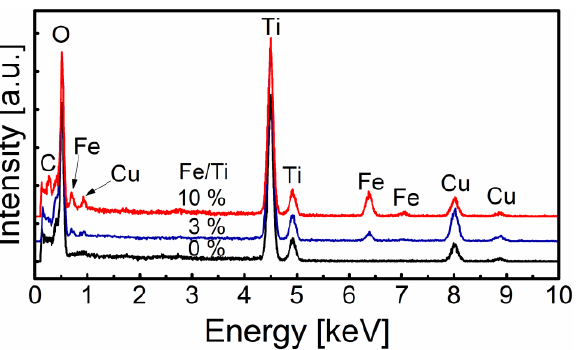
Figure 5. EDS spectra acquired from the region of Figure 4, revealing the existence of Fe in Fe-TiO 2 nanoparticles.